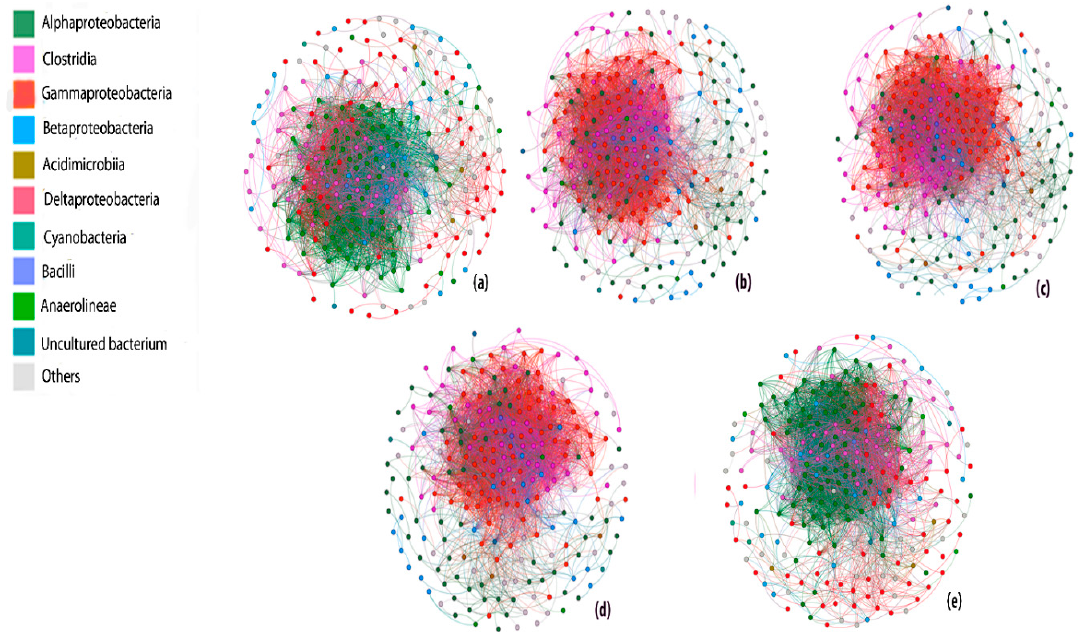
Figure 5. The co-occurrence network analysis of bacterial communities in the order ( a ) 6 ppm 13 CH 4 ( b ) 120,000 ppm 13 CH 4 ( c ) 50 mg L − 1 Pb 2+ + 120,000 ppm 13 CH 4 ( d ) 50 mg L − 1 Cd 2+ + 120,000 ppm 13 CH 4 ( e ) 50 mg L − 1 Cr 6+ + 120,000 ppm 13 CH 4 . The network represents strong (Spearman’s r > 0.8) and significant ( p value < 0.01) correlation. Each node represents a unique sequence in the whole data set, colored nodes (excluding light gray) depicts the ten major groups while light gray represents all other groups.